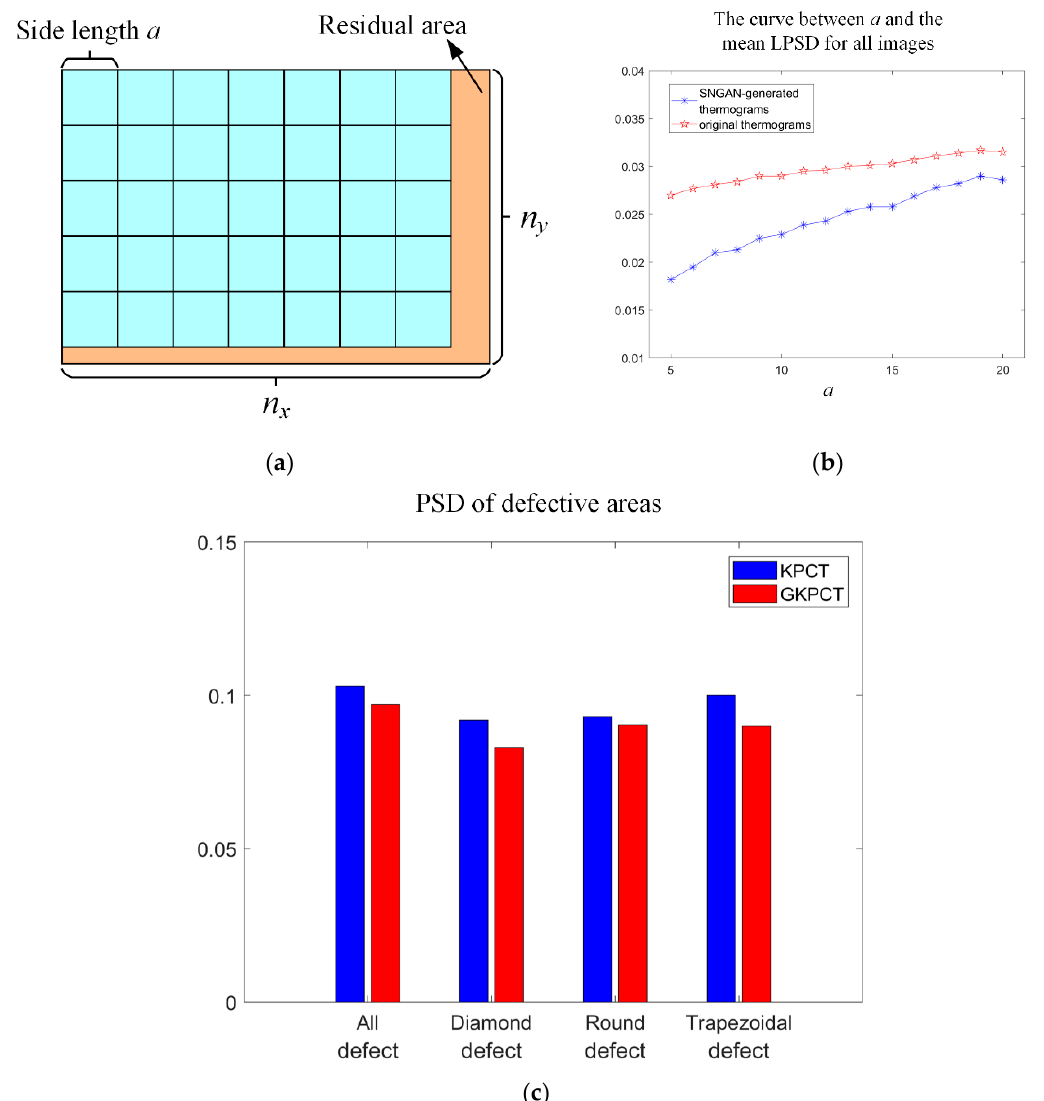
Figure 13. ( a ) Schematic diagram of area division; ( b ) the relationship between LPSD and a ; ( c ) the PSD of the defective areas in KPCT and GKPCT.